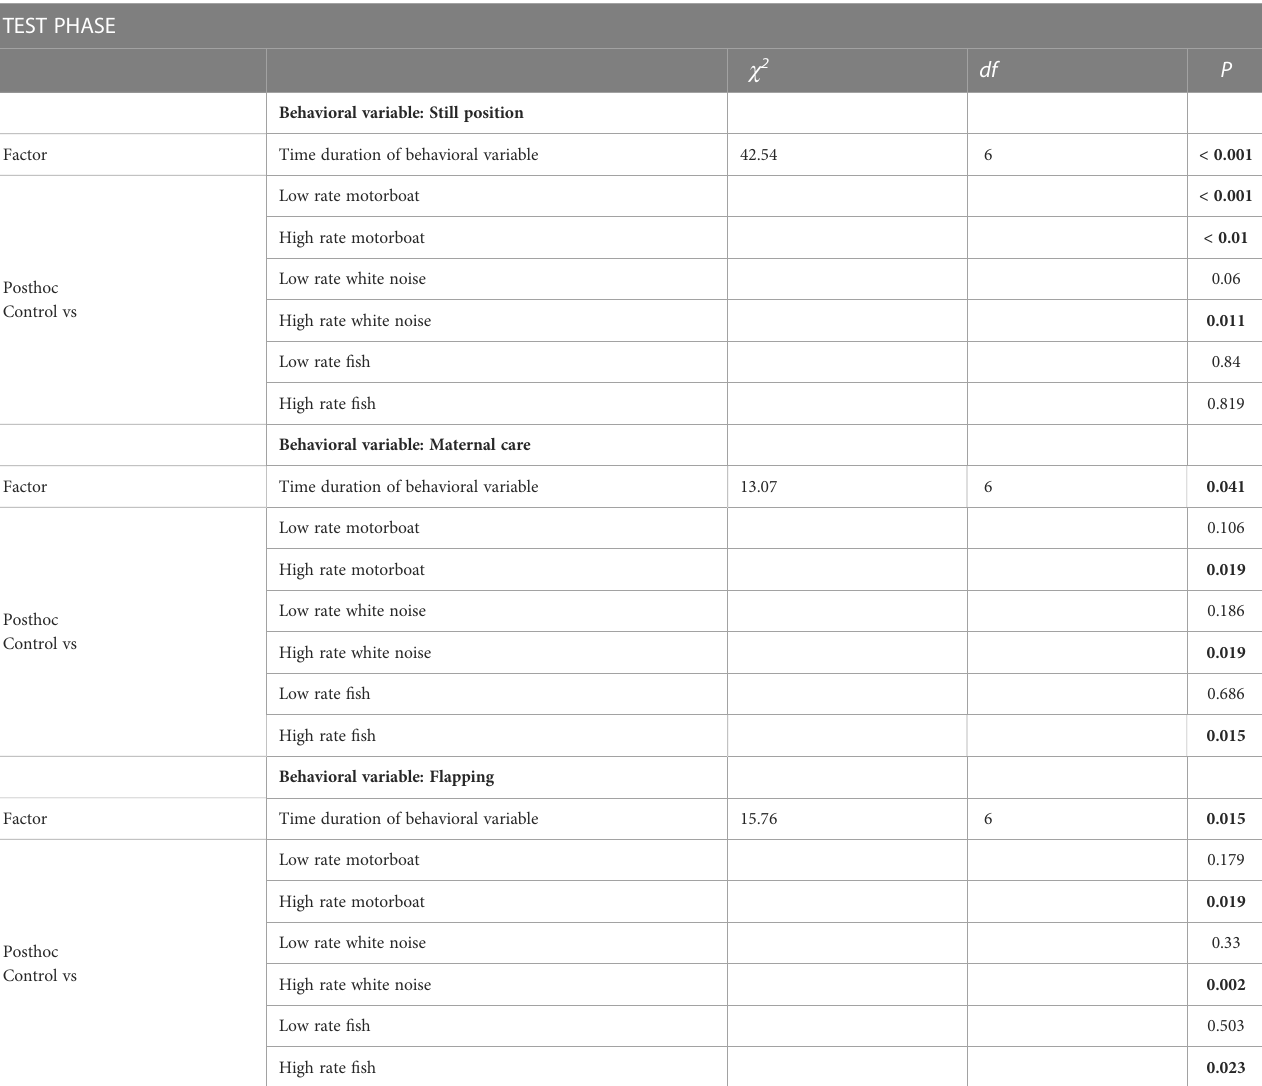
TABLE 1 Results of the GLM of the “ Test phase ” , showing the effects of the sound stimuli (motorboat, white noise, and fi sh) and both temporal emission patterns of sound (low and high rate) on the time duration (sec) of the different behavioral variables quanti fi ed (still position, maternal care ( fl apping + probing), and fl